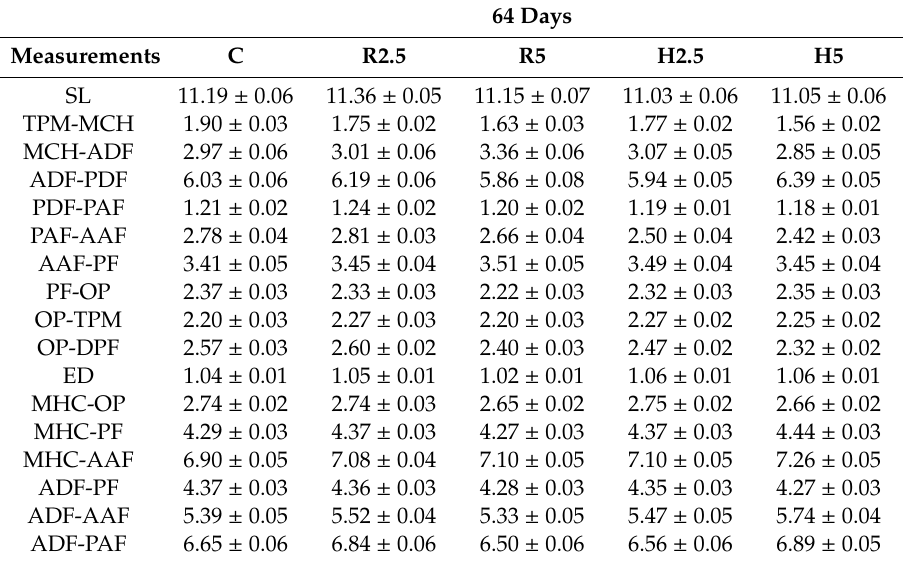
Measurement abbreviations explained in Figure 1. Table 6. Morphological traits of gilthead seabream fed the experimental diets over 64 days. 64